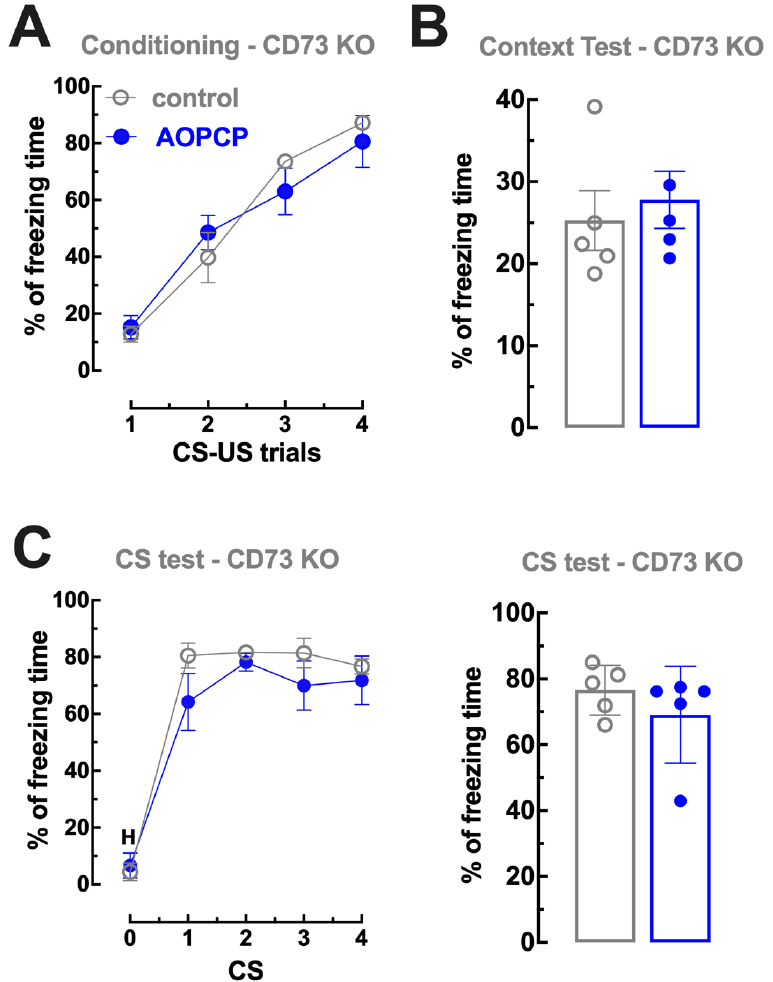
Figure 3. The effect of AOPCP on fear memory is absent in CD73 knockout mice. ( A ) Fear condi- tioning of AOPCP-treated and saline-treated CD73 knockout (KO) mice. The learning curve of cued fear conditioning was similar between AOPCP- and saline-treated mice lacking CD73; moreover, both groups significantly increased their freezing behavior at each CS–US trial, showing a normal lar freezing behavior comparing to the saline-treated group upon re-exposure to the conditioning